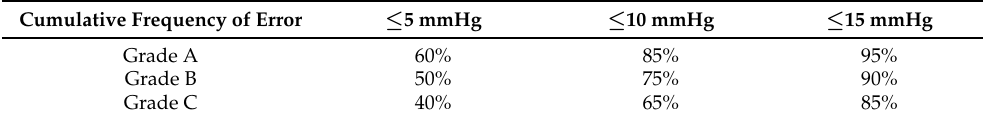
Table 3. BHS standard. The percentage represents the cumulative frequency of